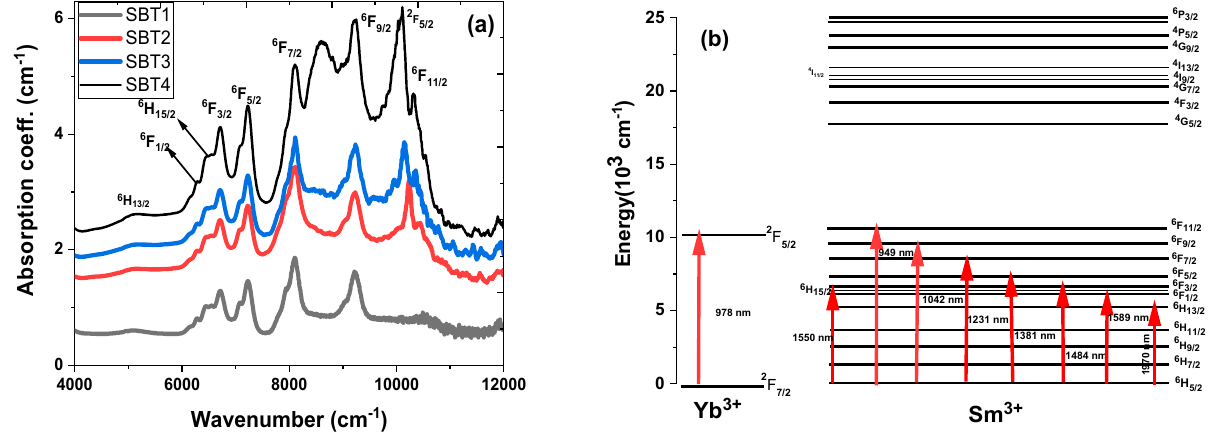
Figure 4. ( a ) Optical absorption coefficient spectra of Sm 3+ and Sm 3+ :Yb 3+ -codoped barium fluorotel- lurite glasses and ( b ) corresponding absorption energy-level diagram.